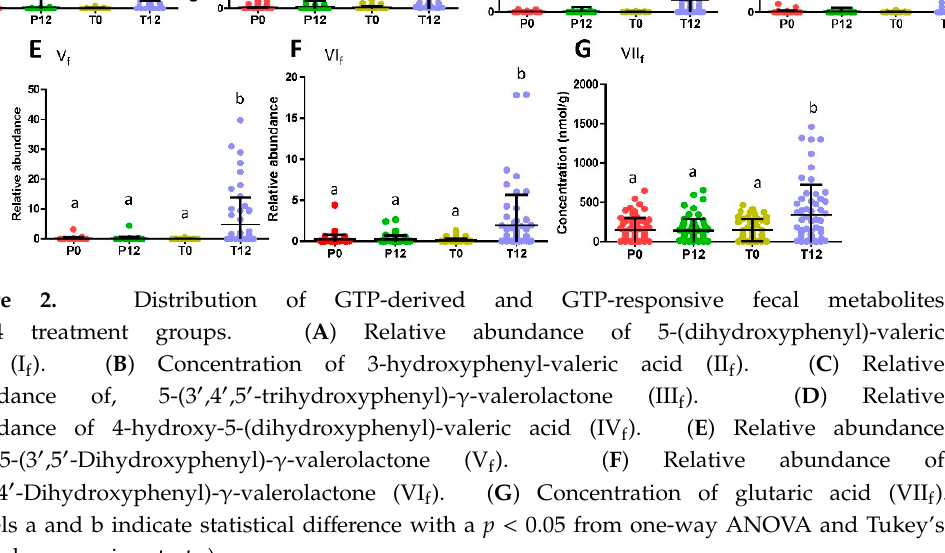
Figure 2. Distribution of GTP-derived and GTP-responsive fecal metabolites in 4 treatment groups. ( A ) Relative abundance of 5-(dihydroxyphenyl)-valeric acid (I f ). ( B ) Concentration of 3- hydroxyphenyl-valeric acid (II f ). ( C ) Relative abundance of, 5-(3 ′ ,4 ′ ,5 ′ -trihydroxyphenyl)- γ - valerolactone (III f ). ( D ) Relative abundance of 4-hydroxy-5-(dihydroxyphenyl)-valeric acid (IV f ). ( E ) Relative abundance of 5-(3 ′ ,5 ′ -Dihydroxyphenyl)- γ -valerolactone (V f ). ( F ) Relative abundance of 5-(3 ′ ,4 ′ -Dihydroxyphenyl)- γ -valerolactone (VI f ). ( G ) Concentration of glutaric acid (VII f ). (Labels a and b indicate statistical difference with a p < 0.05 from one-way ANOVA and Tukey’s multiple comparison tests.).